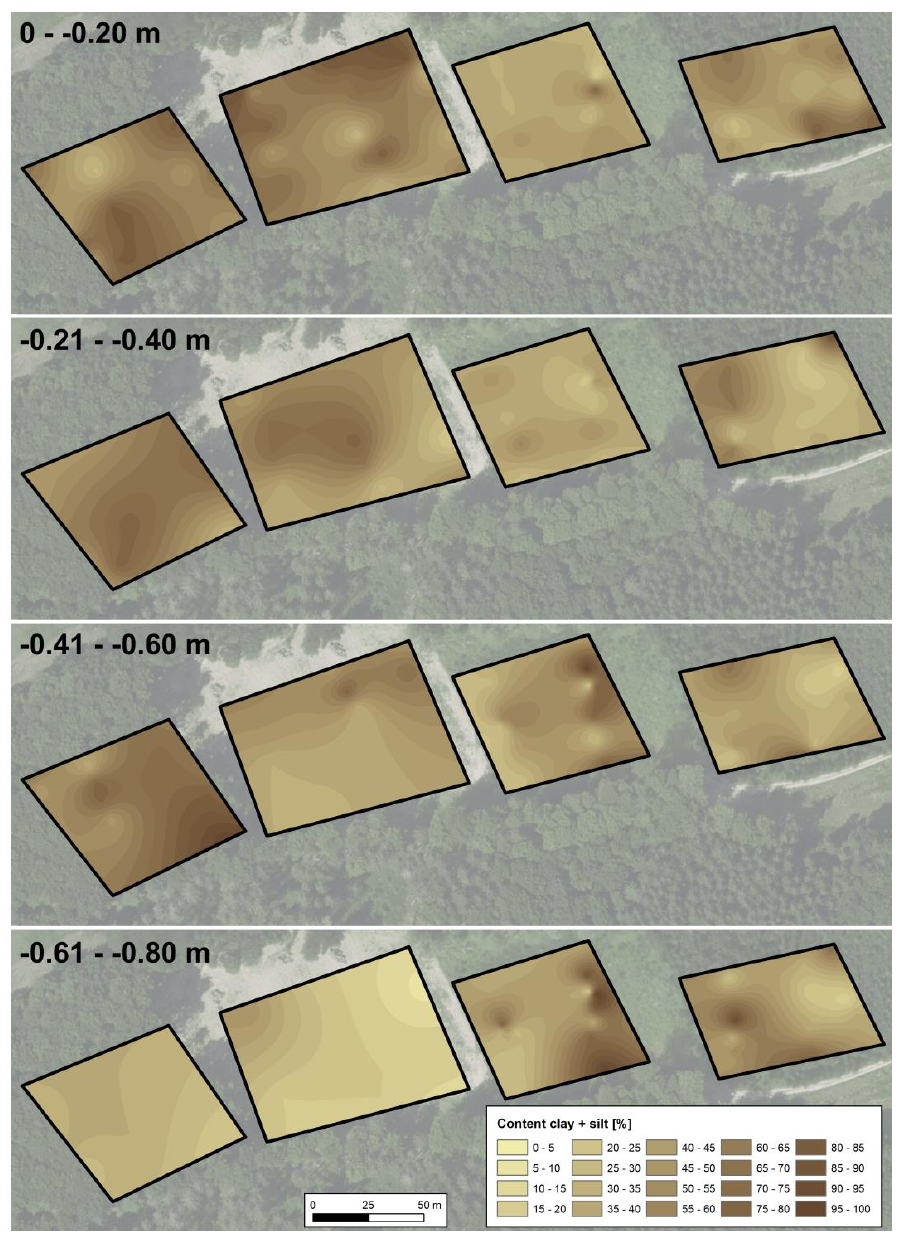
Figure 10. Interpolated content clay + silt. Aerial photography provided by LVermGeo RLP (2019). Table 8. Root mean square error (RMSE) interpolated raster clay +